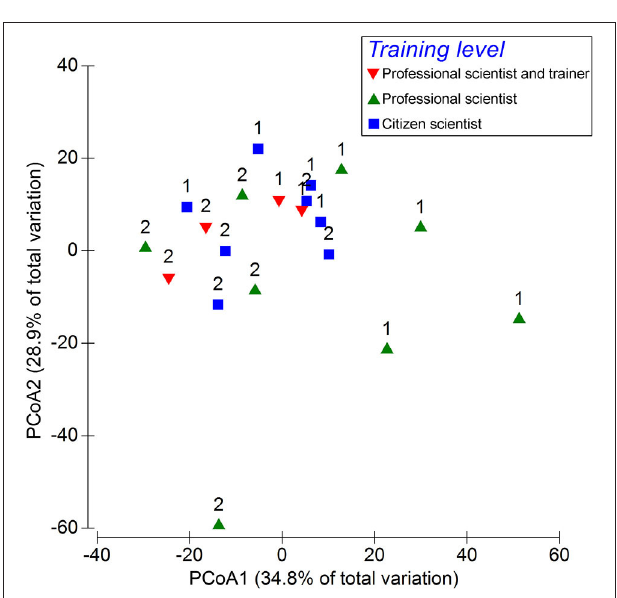
FIGURE 3 | Android smartphone app screenshots: (A) main menu; (B) maps with previously investigated sites; (C) initial part of the data entry form; and (D) final part of the data entry form.